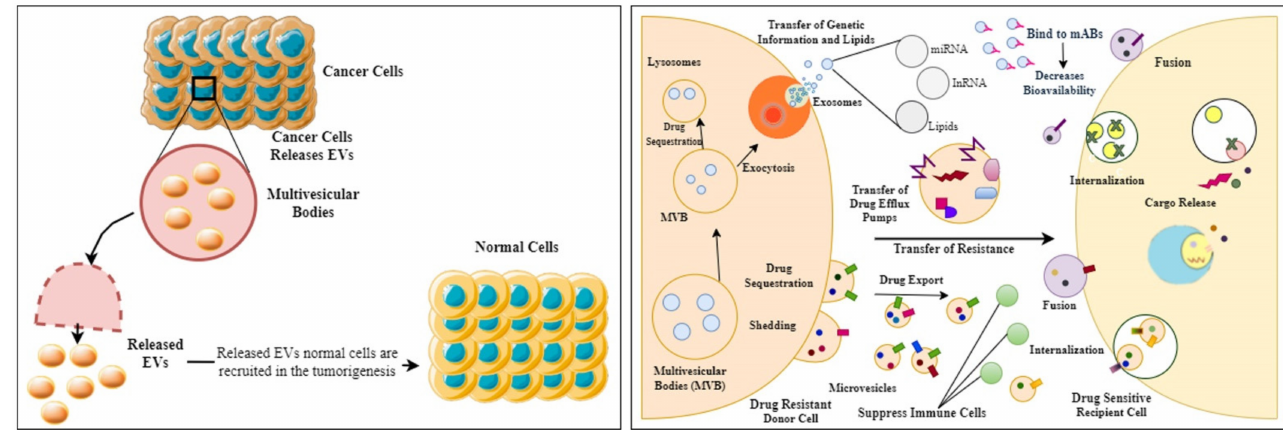
Figure 2. Diagrammatic representation showing how cancer cell-derived EVs promote tumorigenesis in normal cells and later help the drug-sensitive cells to transform into drug-resistant cells, thus owing to failed